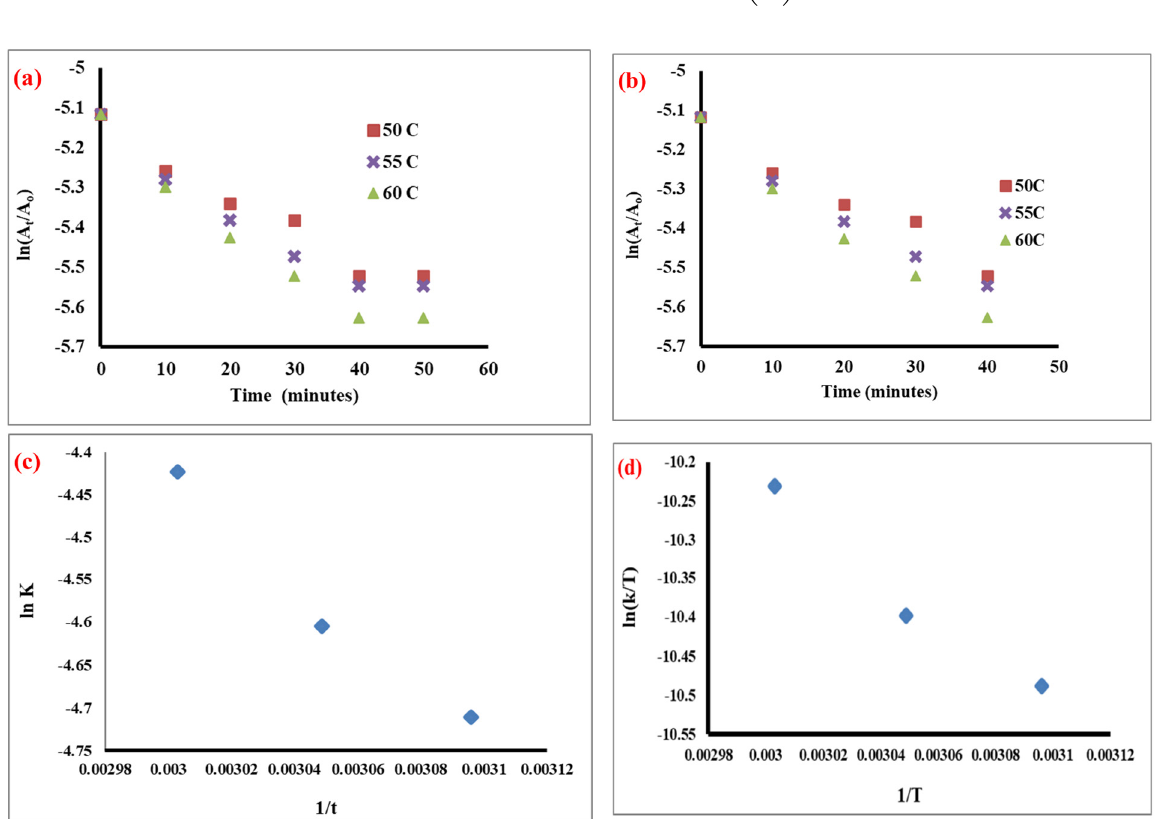
Figure 7. Graph expressing the relationship between ln(A t /A o ) and the time of the transesterification reaction at 50 °C, 55 °C, and 60 °C, showing the progress of the reaction. ( a ) Linear portion of the graph expressing the relationship between ln(A t /A o ) and the time of the transesterification reaction at 50 °C, 55 °C, and 60 °C, used to calculate k app for the transesterification reaction. ( b ) Arrhenius plot comparing ln(k) and 1/T for the calculation of the energy of activation of the transesterification reaction. ( c ) Eyring plot comparing ln(k/T) and 1/T for the calculation of the enthalpy and entropy of the transesterification reaction ( d ).